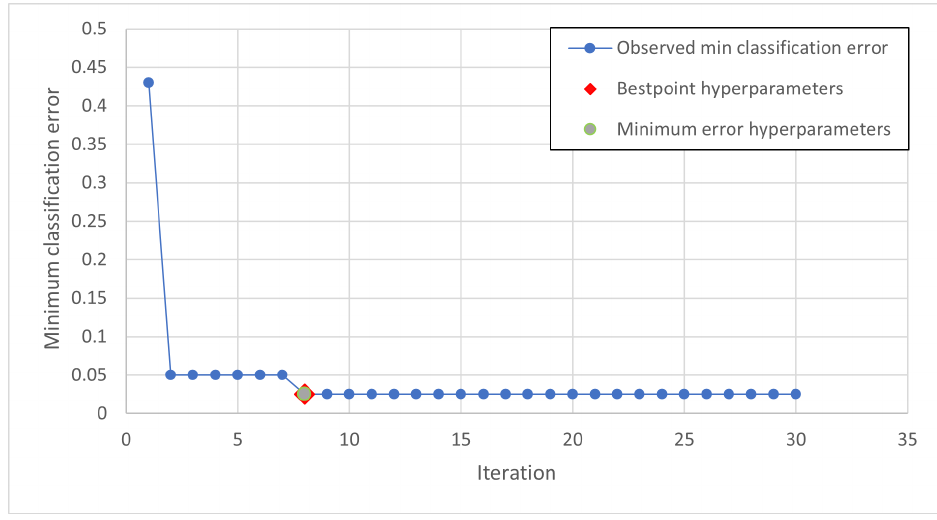
Figure 12. SVM classification error.